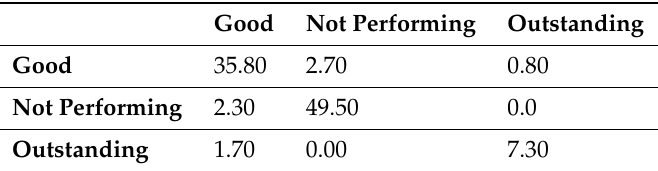
Table 8. Cross-Validated (20 fold) Confusion